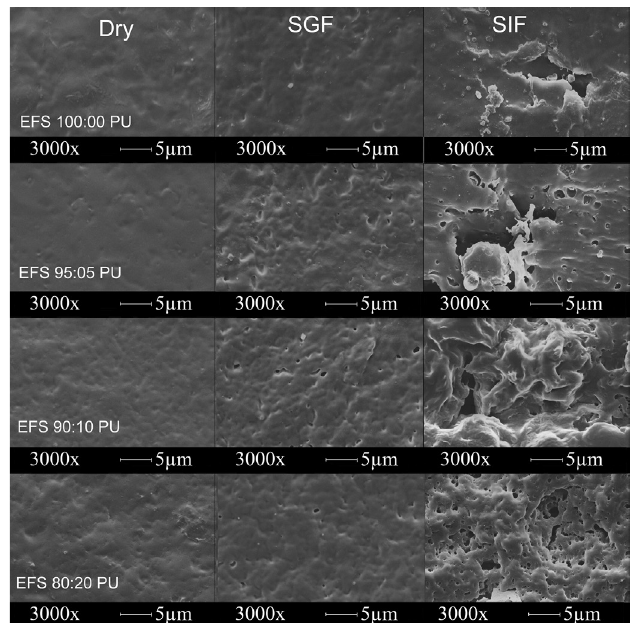
FIGURE 6 - SEM of dry EFS:PU films and after immersion for 180 min at SGF and SIF (3000x